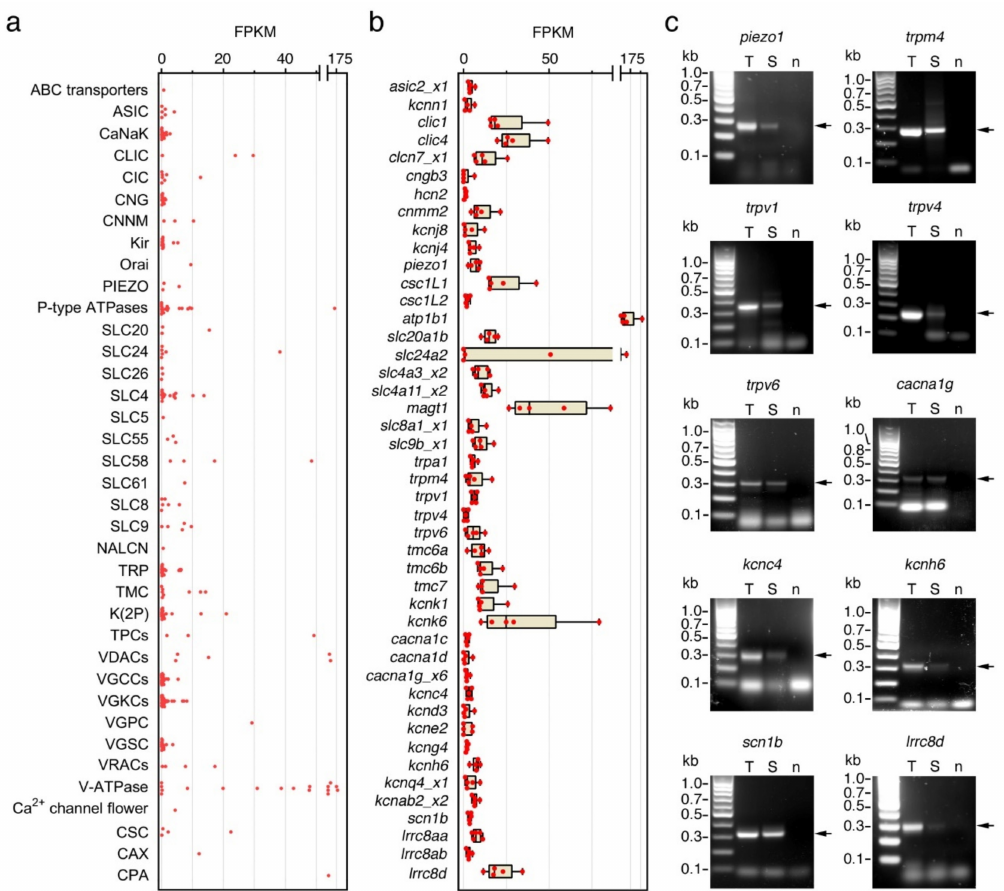
Figure 5. Ion channel-encoding genes expressed in ejaculated seabream spermatozoa. ( a ) Plot showing the mean expression levels of all the 342 genes assessed as fragments per kilo base per million mapped reads (FPKM) of the corresponding transcripts. ( b ) Levels of expression of the most abundant transcripts encoding for ion channels potentially localized in the plasma membrane of the spermatozoa determined in 5 replicate RNA-seq libraries of ejaculated spermatozoa (each replicate being a pool of cells collected from three different males). Data points are presented as box and whisker plots/scatter dots with horizontal line (inside box) indicating median and outliers. Data in a and b were calculated from a recent RNA-seq analysis on seabream spermatozoa reported by Castro-Arnau et al. [30] (Gene Expression Omnibus database accession no. GSE173088, National Center for Biotechnology Information). ( c ) Representative RT-PCR detection of mRNAs encoding selected ion channels in testis (T) and ejaculated spermatozoa (S). The n line is the negative control (absence of RT during cDNA synthesis). The arrows indicate the specific amplified transcripts, and the size (kb) of molecular markers are indicated on the left. Uncropped gels are shown in Supplementary Figure S2). See Spreadsheets S1 and S2 for abbreviations and gene